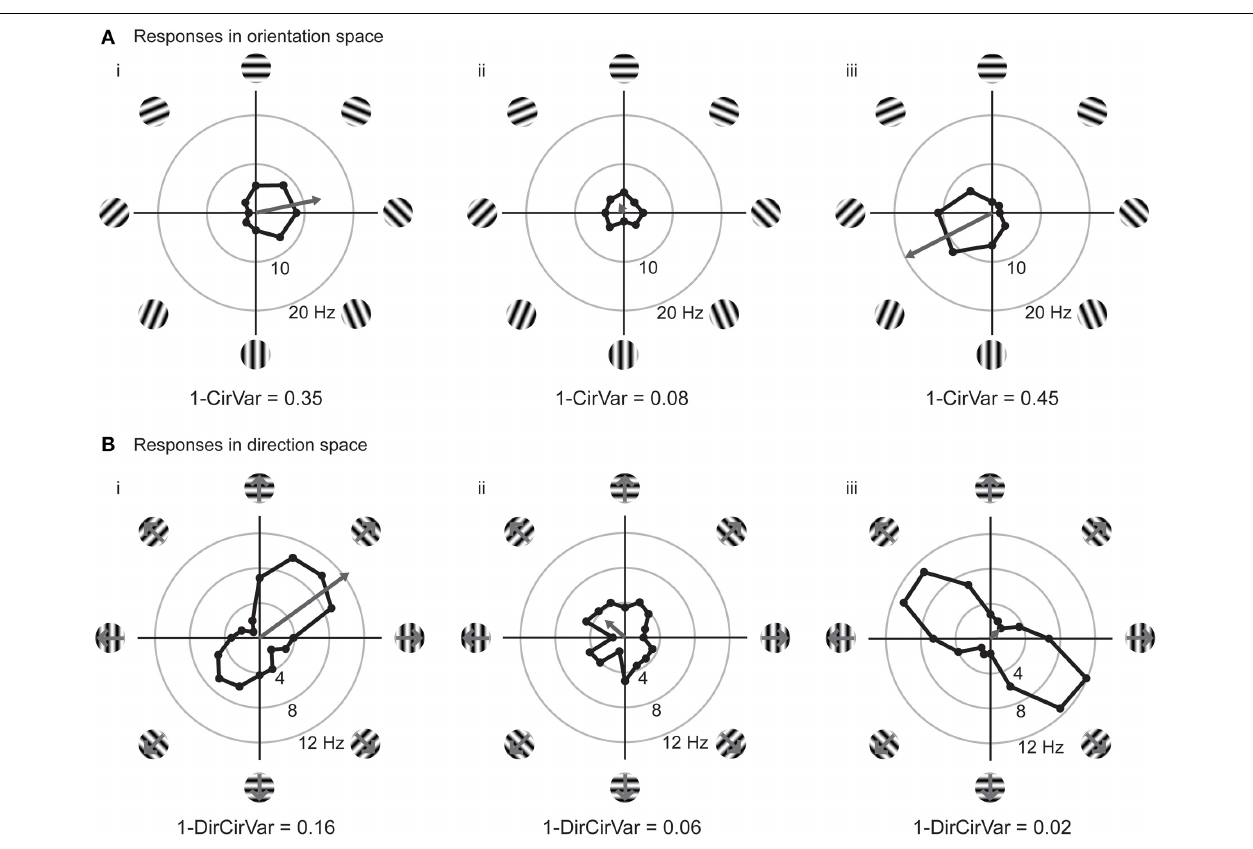
FIGURE 3 | Responses of model cells in polar coordinates on the complex plane. (A) Responses of model cells in orientation space. Response (in spikes per second) at each angle is indicated by the distance from the origin. Orientation angles vary from 0 (horizontal) to 90 ◦ (vertical) and back to 0 ◦ /180 ◦ (horizontal). Gray arrow indicates the vector mean of the responses to individual orientations. The normalized length of the mean response vector is the quantity L ori , which is 1minus the circular variance (1- CirVar ). Model cells i and ii are the